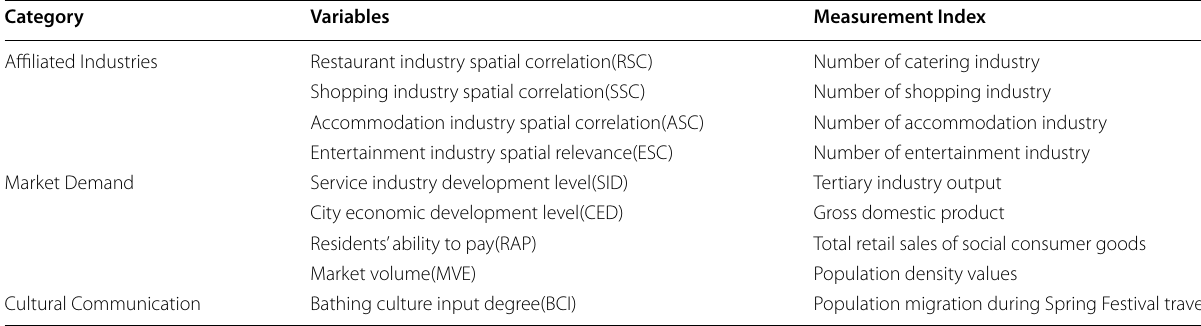
Table 3 Index of the impact factor